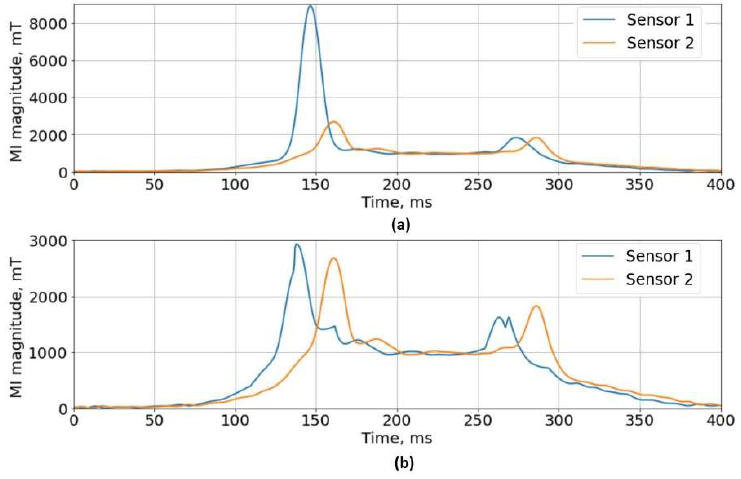
Figure 7. ( a ) Original pair of magnetic signatures, ( b ) corrected pair of signatures.